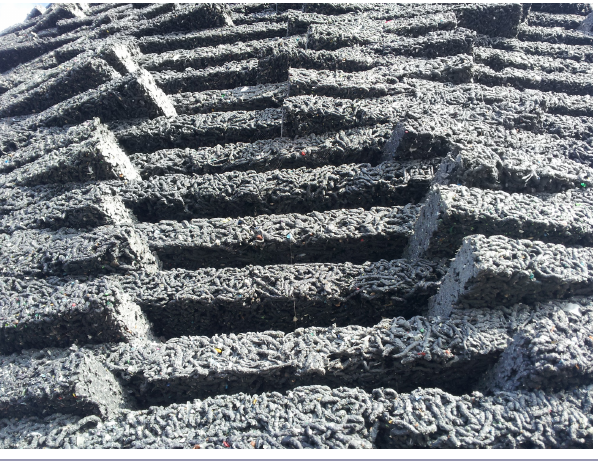
Fig. 3 . Close-up shot of Cone showing the composition